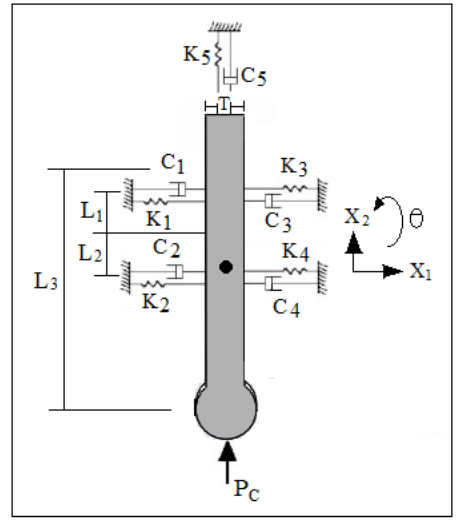
Figure 1. Vibration of the follower stem.